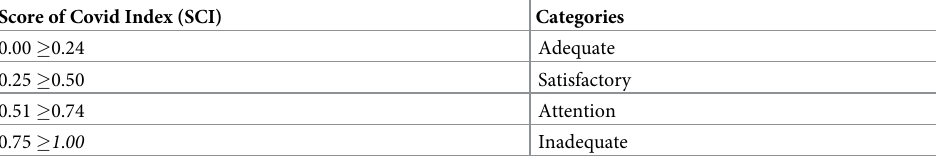
Table 2. Covid index